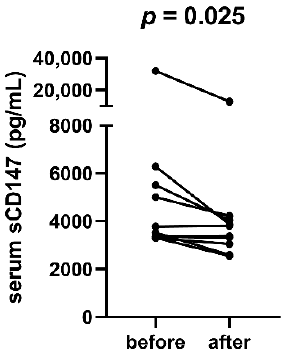
Figure 5. Serum sCD147 levels in multiple myeloma patients before and after positive response to treatment. sCD147 levels are decreased in most patients after remission ( p = treatment. sCD147 levels are decreased in most patients after remission ( p = 0.025).